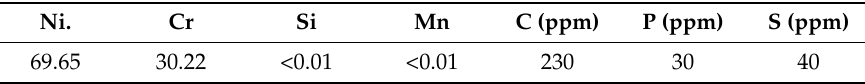
Table 1. Chemical composition (mass percentages) of NiCr